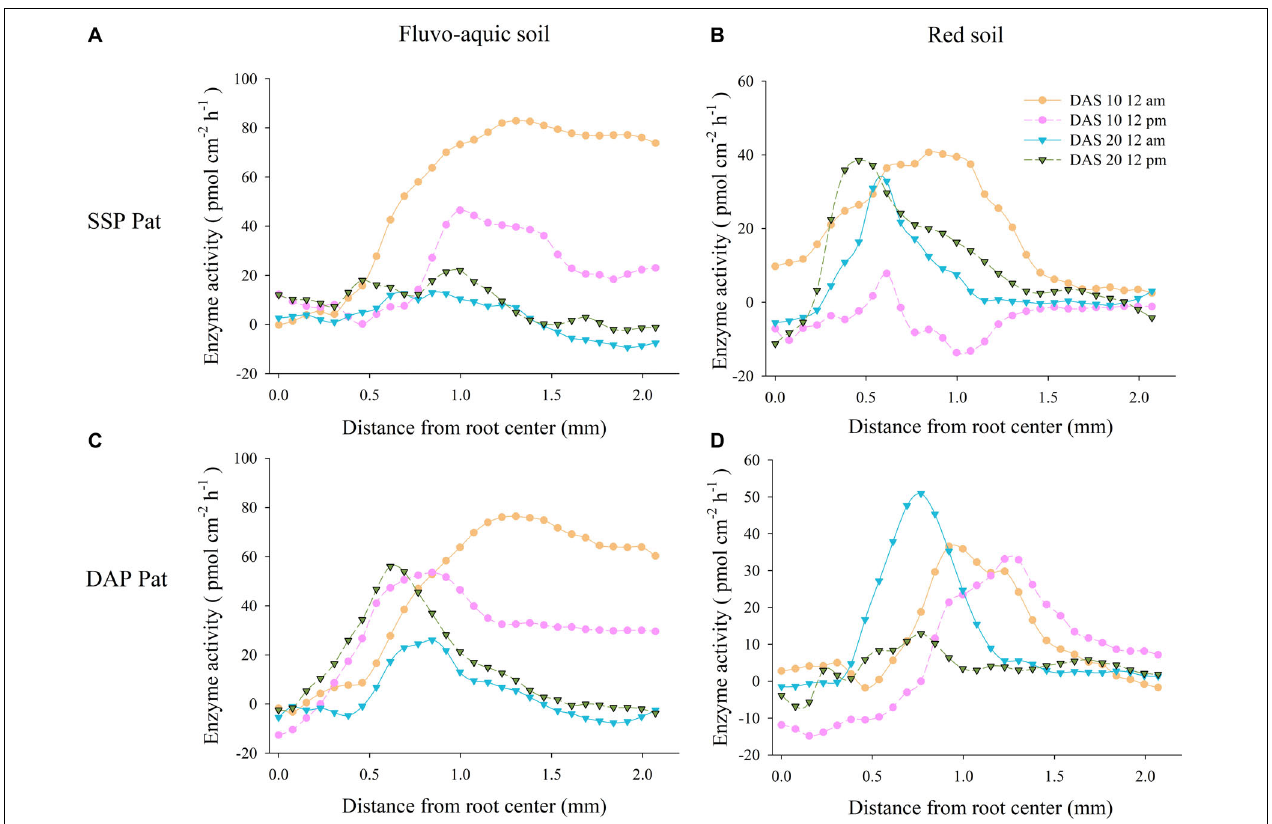
FIGURE 11 | The difference between acid phosphatase activity in rhizosphere of P-rich patches and contrast areas with localized P supply. (A,B) Represents results of SSP Pat in fluvo-aquic soil and red soil, (C,D) represents results of DAP Pat in fluvo-aquic soil and red soil. Each line calculated from four replicates, error bars are omitted to improve